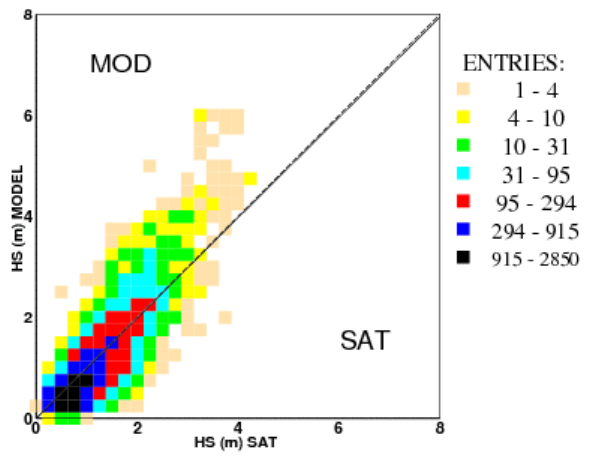
Fig. 8. Scatter diagram of the model significant wave heights (anal- Figure 8 – Scatter diagram of the model significant wave heights (analysis) vs the corresponding ysis) vs the corresponding ENVISAT altimeter data. The considered ENVISAT altimeter data. The considered period is 2005-2010. The different colours show (right period is 2005–2010. The different colours show (right scale) how scale) how many cases belong to each pixel. Overall, 21,605 data is considered. many cases belong to each pixel. Overall, 21605 data are consid- ered.